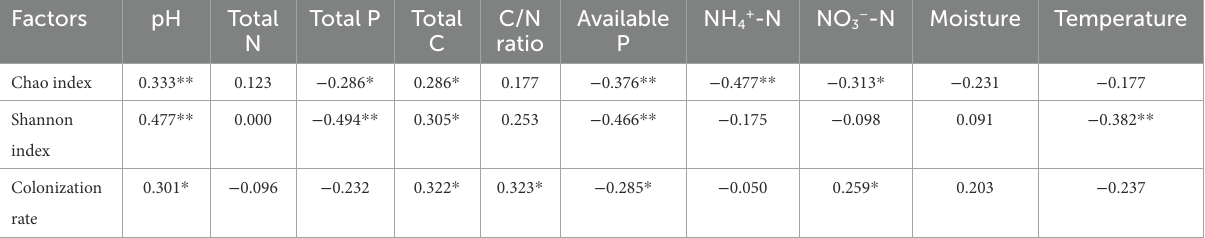
TABLE 3 Spearman correlation coefficients between the diversity of the AM fungal community and environmental factors ( n = 60).